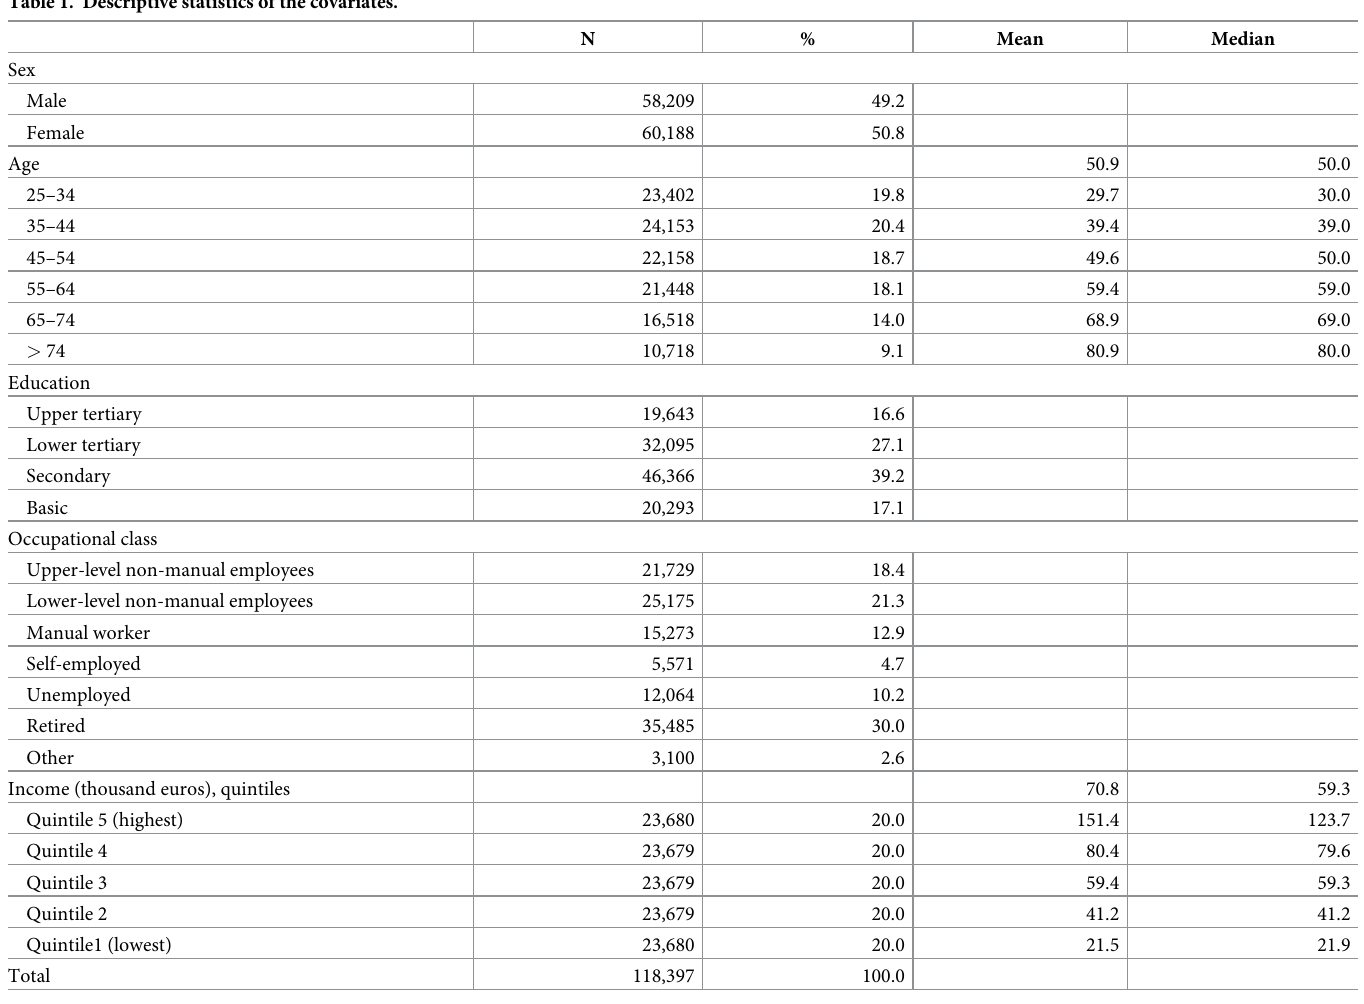
Table 1. Descriptive statistics of the